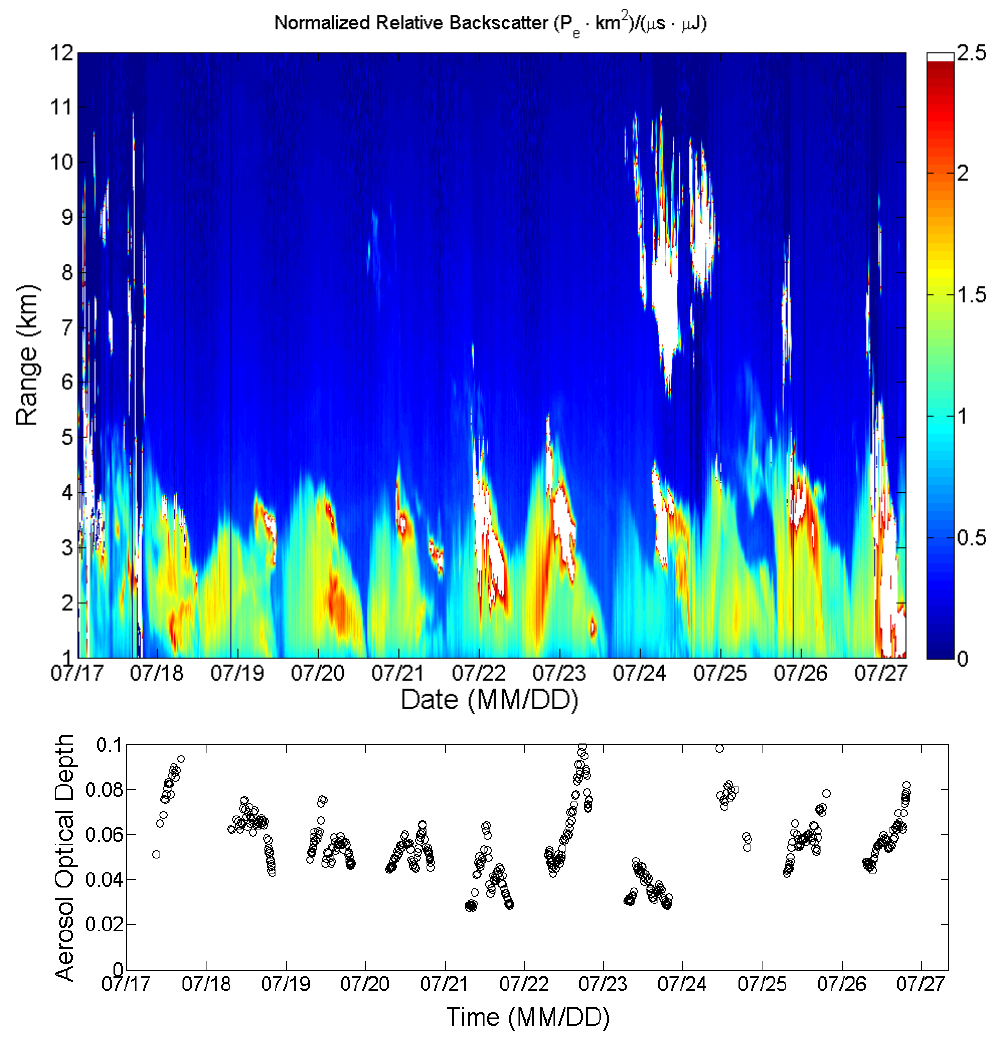
Figure 5. A plot of the normalized relative backscatter as a function of range and time is shown in the upper plot. The corresponding aerosol optical depth at 830 nm measured with a co-located solar radiometer as part of the NASA AERONET program is shown in the bottom